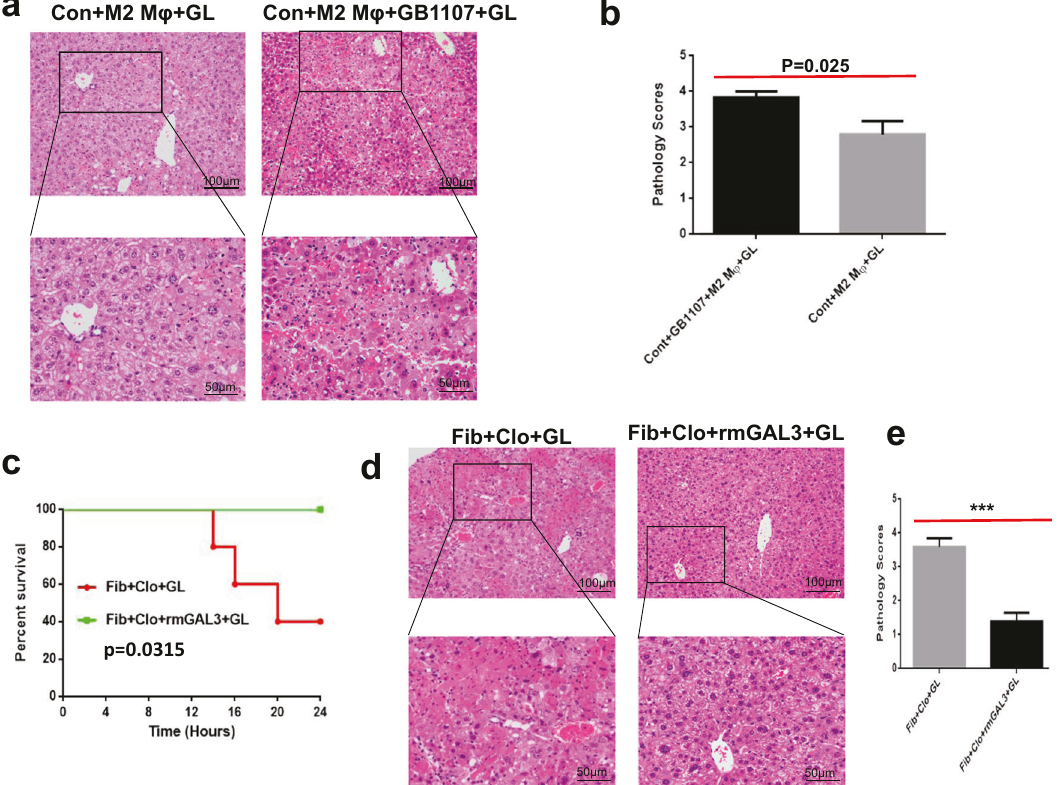
Fig. 5 GAL3 holds a pivotal place in the hepatoprotection conferred by M2-like macrophages. a , b Hepatic histology and pathology scores in acutely injured mice subjected to M2-like macrophage transfer with or without GB1107 treatment ( n = 5 – 6). Group comparisons were performed using Student ’ s t test. c Comparison of the survival rate in fi brotic mice upon macrophage depletion and acute insult with or without recombinant GAL3 treatment ( n = 5 – 6). The log-rank test was used to compare the differences in survival between treatment groups. d , e Hepatic histology and pathology scores in fi brotic mice upon macrophage depletion and acute insult with or without recombinant GAL3 treatment ( n = 5). Group comparisons were performed using Student ’ s t test, *** P <